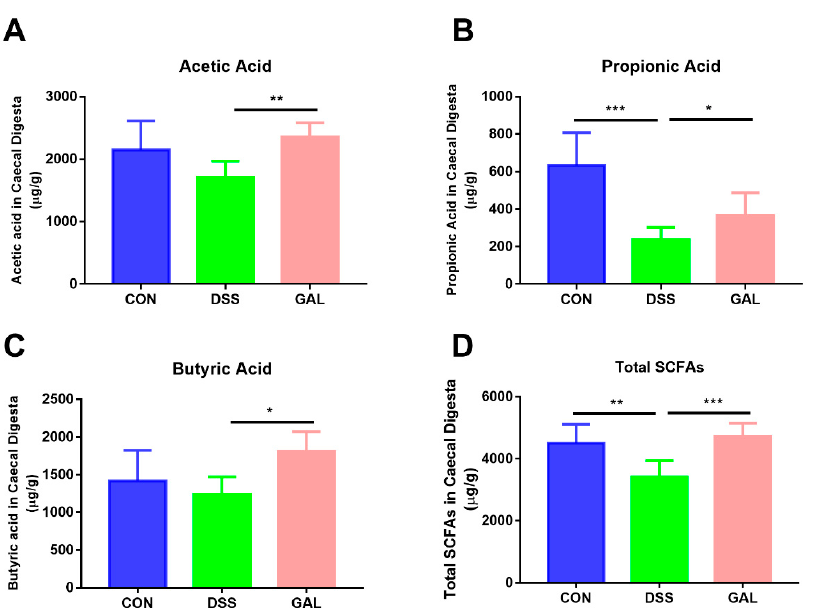
Figure 5. Galangin administration increased gut SFCAs in DSS-induced colitic mice. Feces were collected from mice and SCFAs were analyzed using GC. Results of acetic acid ( A ), propionic acid ( B ), butyric acid ( C ), and total SCFAs ( D ) are shown as µ g / g of feces f.w. (fresh weight). The stars indicate that values were significantly different (* p < 0.05, ** p < 0.01, and *** p < 0.001) compared with DSS control.